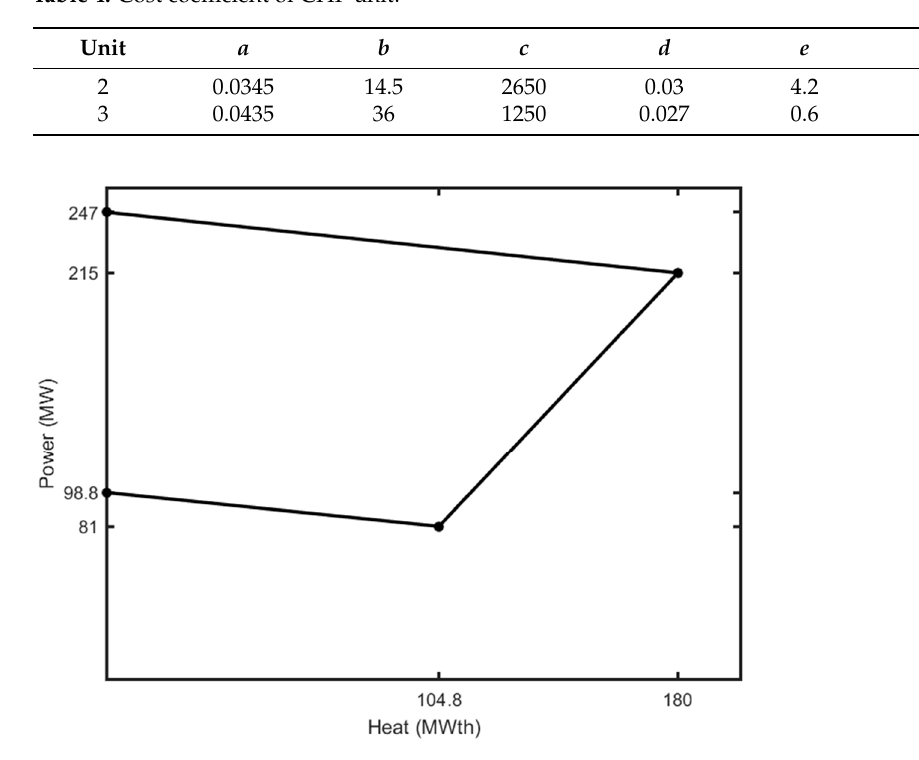
Table 4. Cost coefficient of CHP unit.